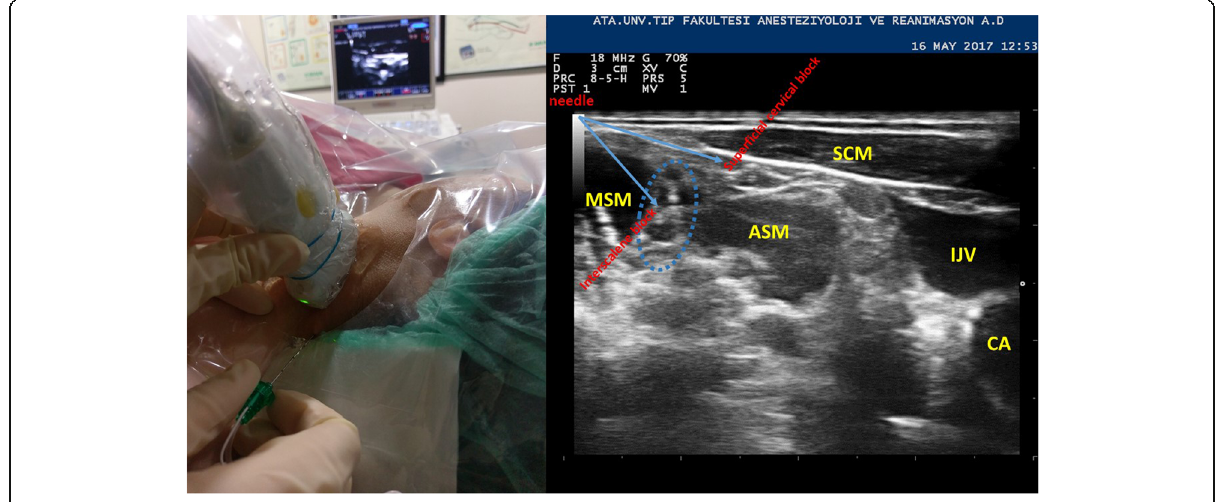
Fig. 1 Patient, probe, and ultrasound setup for block with sonographic anatomy of interscalene-superficial cervical block area. SCM sternocleidomastoid muscle, ASM anterior scalene muscle, MSM middle scalene muscle, IJV internal jugular vein, CA carotid artery